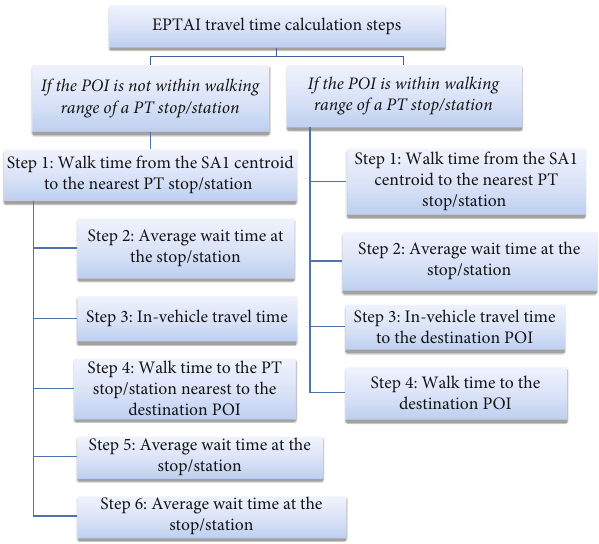
Figure 1: The framework EPTAI travel time calculation